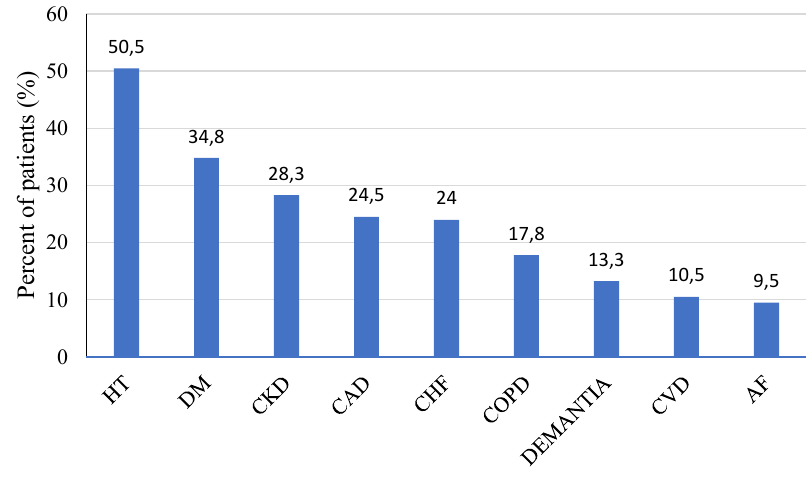
Figure 1: Most common